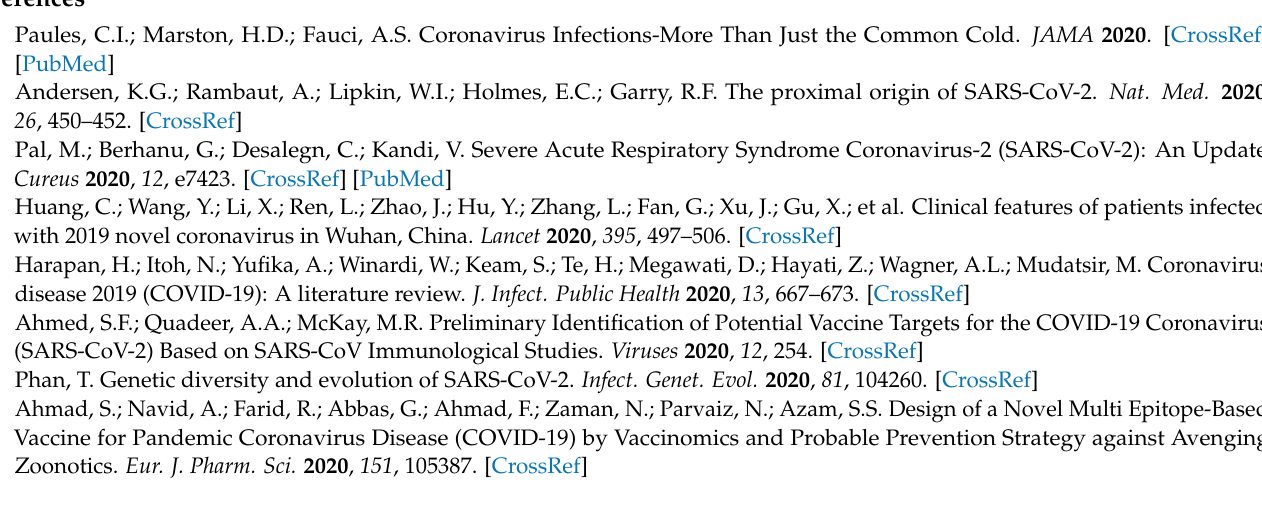
humans. Figure S1: Mean CAI value and Expected CAI value of SARS-CoV-2 strains against its host Humo